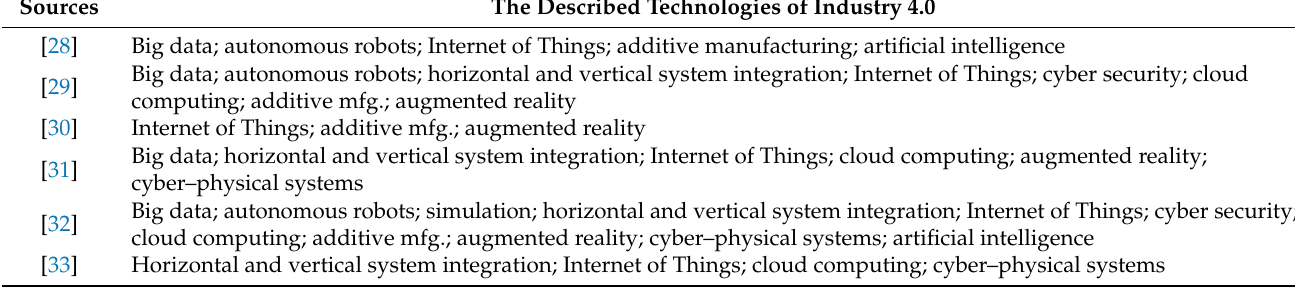
Table 1. Basic technologies of Industry